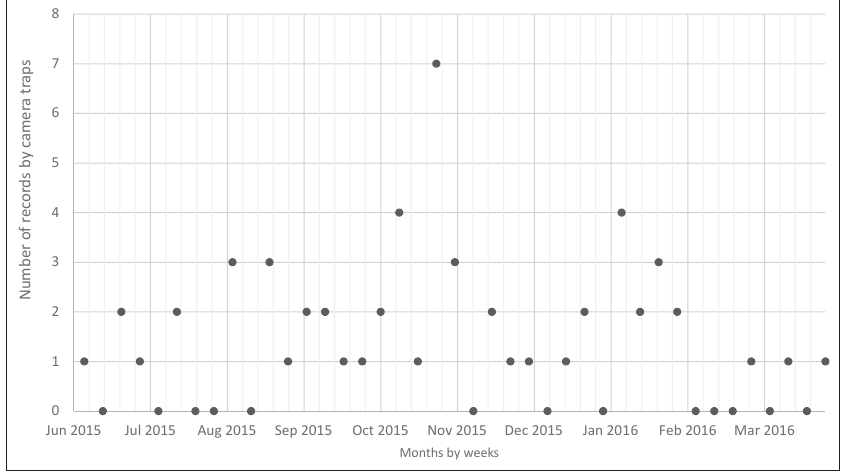
Figure 3. Distribution of the records of golden jackal. The numbers of photographs per week are